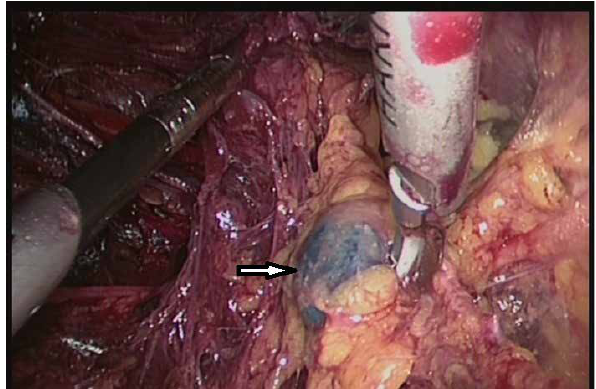
Figure 1: Blue dye sentinel lymph node hanging on the fibrous cord as seen from the screen